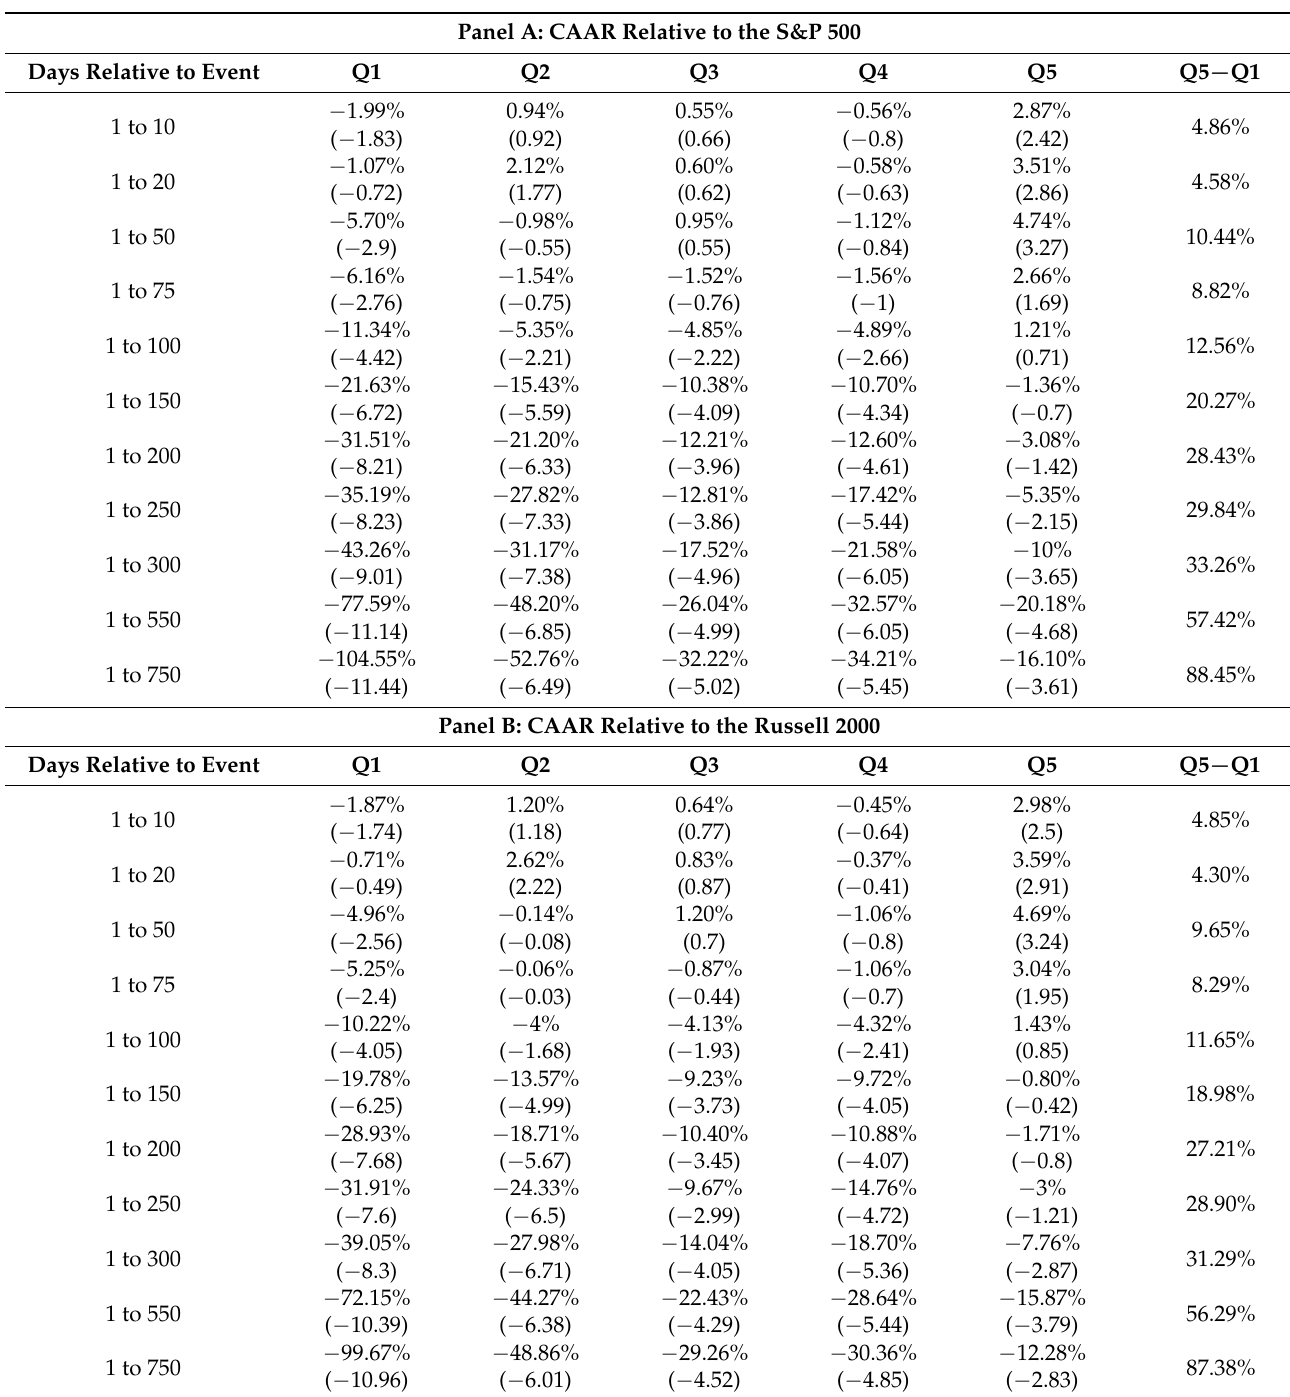
Table 6. Size (Assets before the IPO)-Ranked Portfolios and the Performance of IPOs. Panel A: CAAR Relative to the S&P